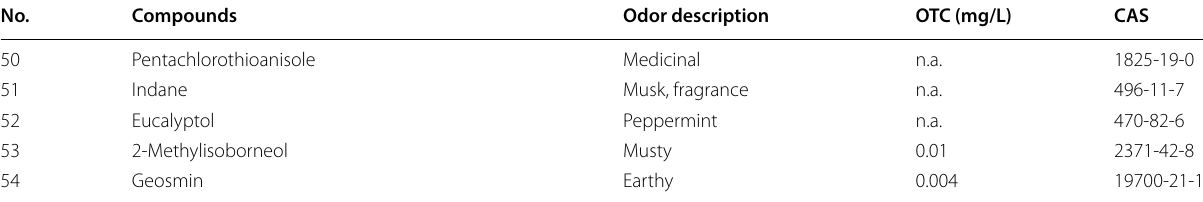
Table 3 FPA evaluation results of two reservoirs